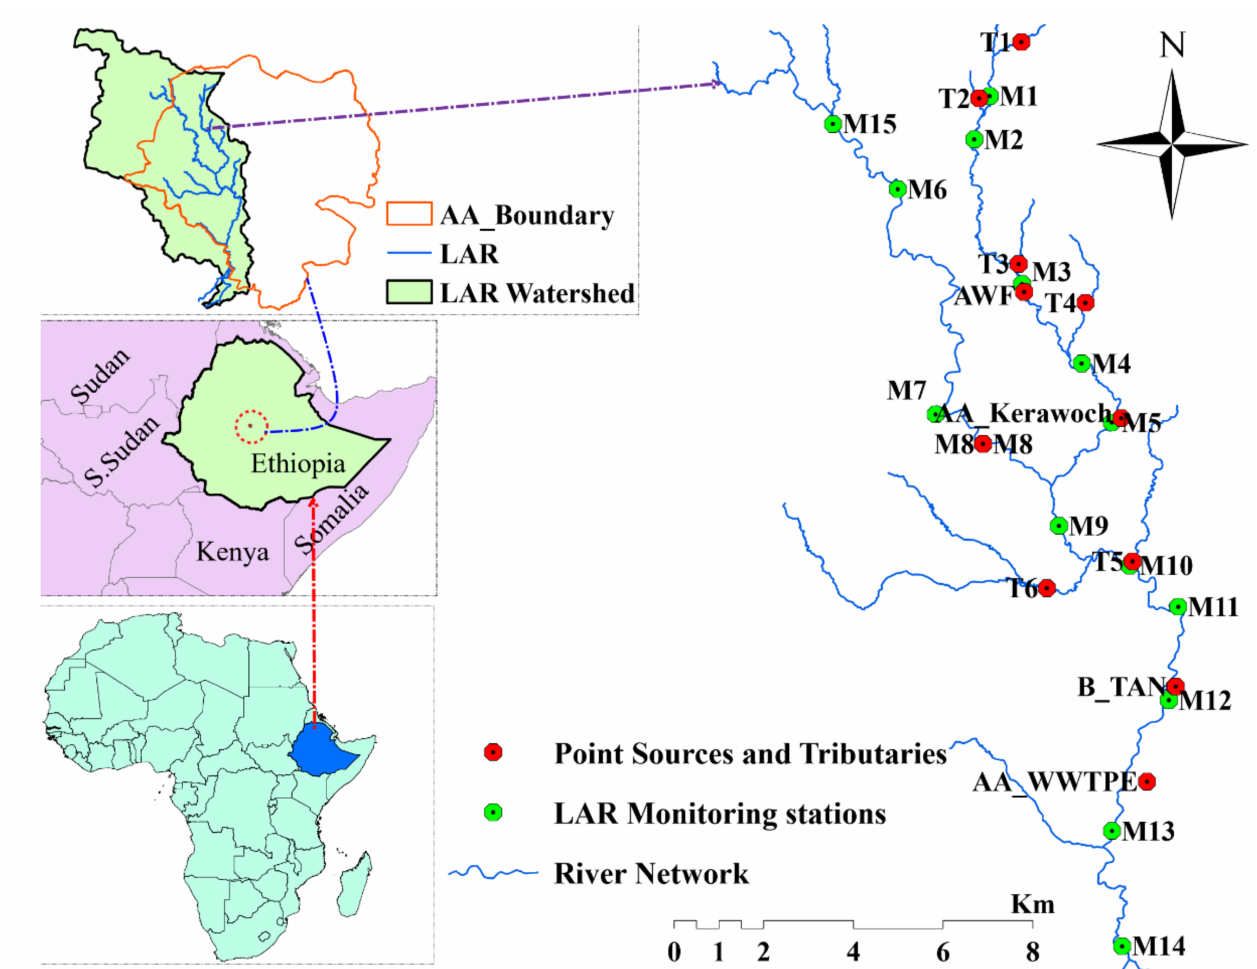
Figure 1. The LAR water quality monitoring stations and point source locations (AA = Addis